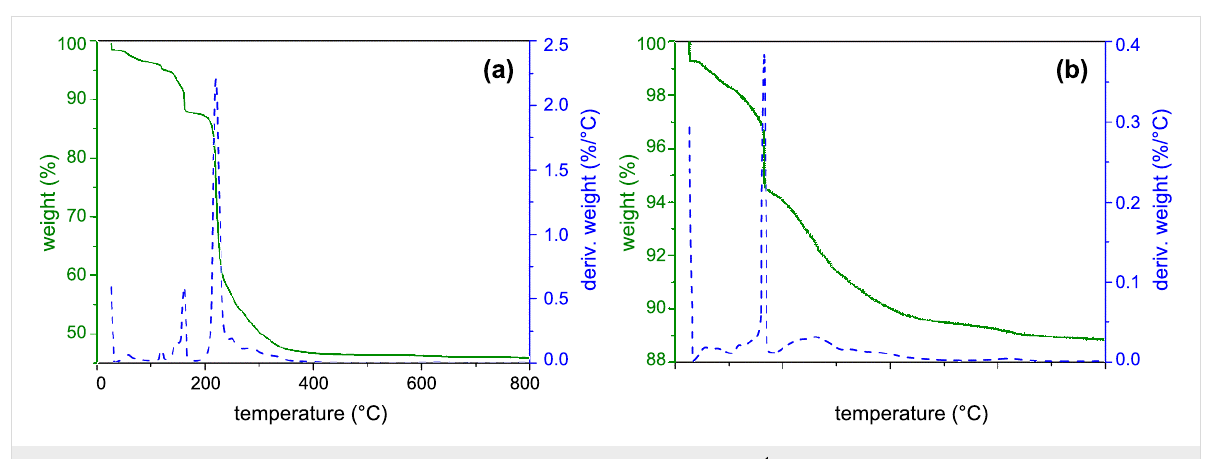
Figure 5: TG and DTG of (a) DT-coated and (b) THMA-coated ZnO obtained in air at 5 °C·min − 1